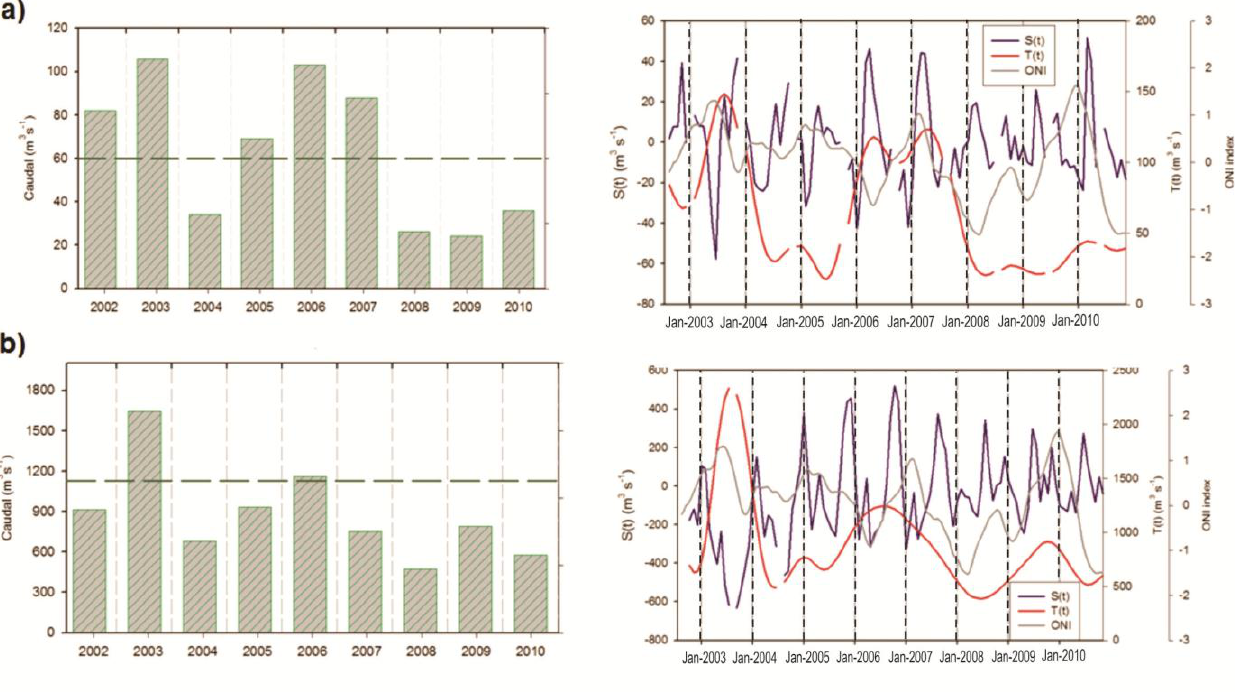
Figure 12. Main river causal variability between 2002 and 2010. The left column is for the total annual discharge ( in situ ) (grey bars) and the mean historical discharge (dashed line). Right column stands for the Census X-11 statistics and the ONI. ( a ) Colorado River; and ( b ) Negro